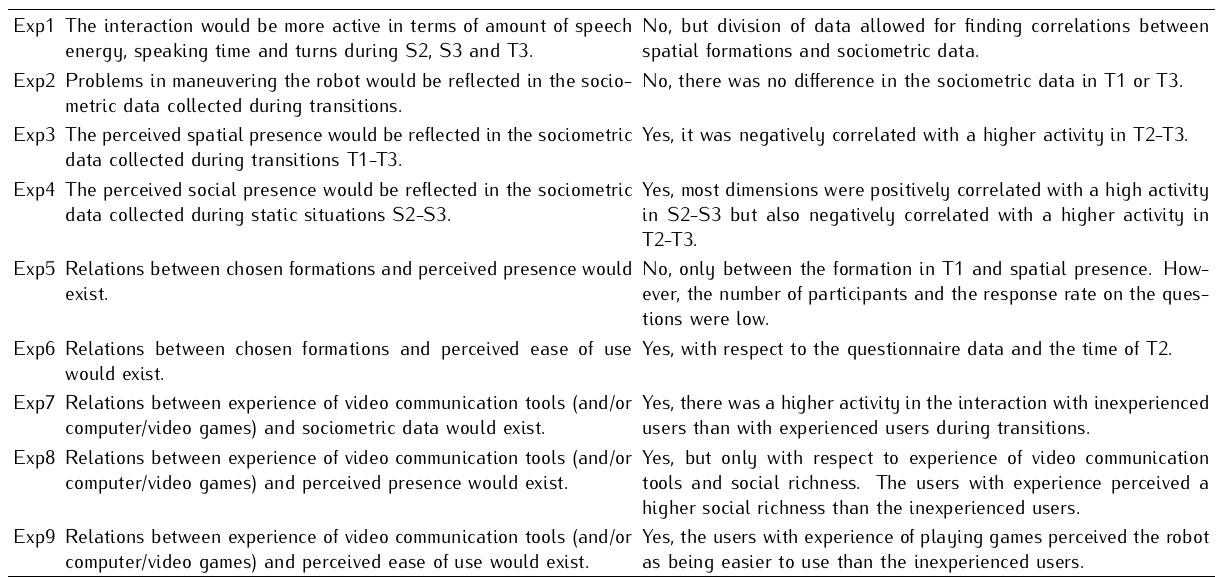
Table 12. A summary on how the experiment expectations